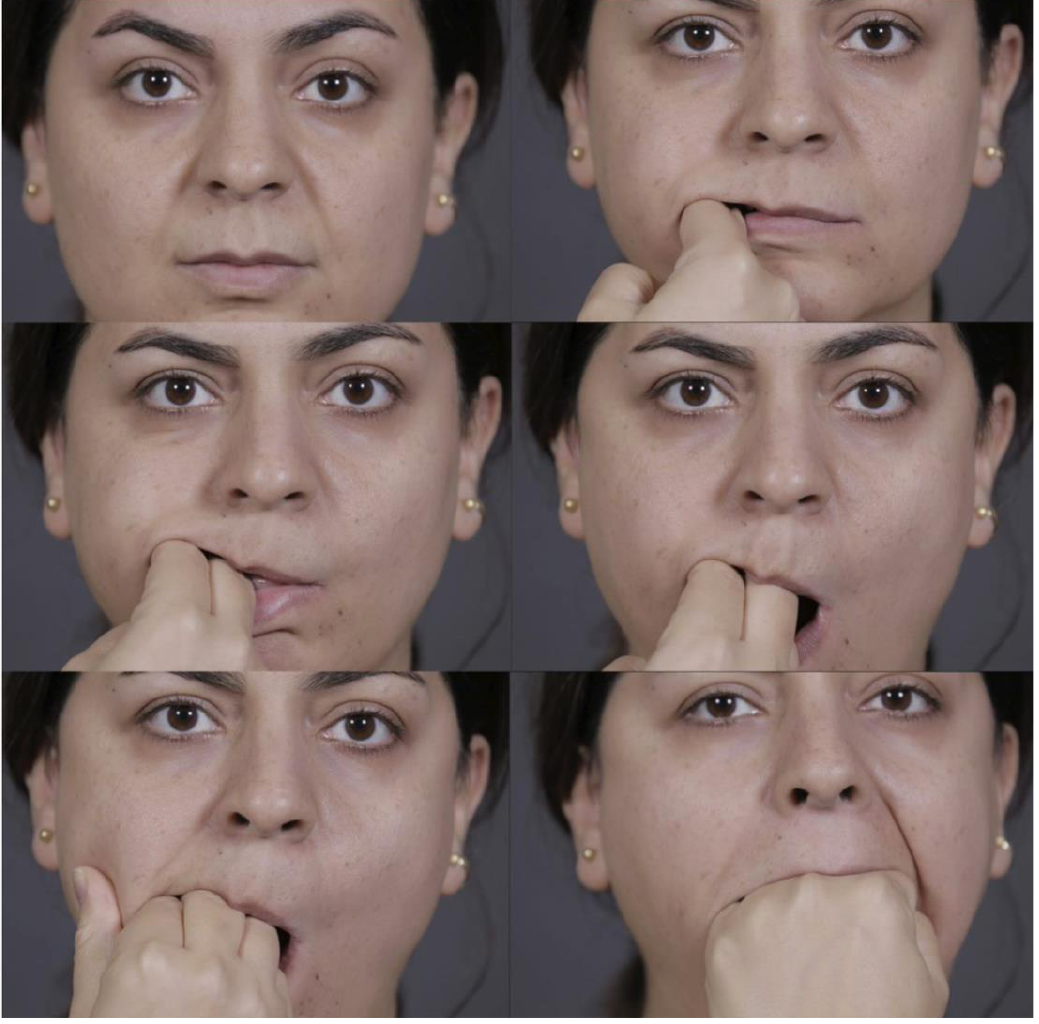
Sepideh Tajalizadeh Dashti, Don’t Ask I Can’t Sing , 2018. Film